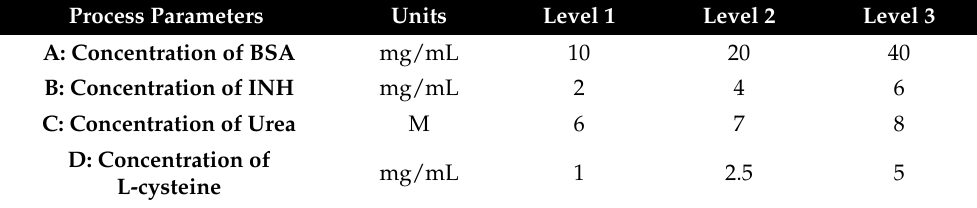
Table 1. Taguchi L9 experimental design for the production of BSA-INH NPs.